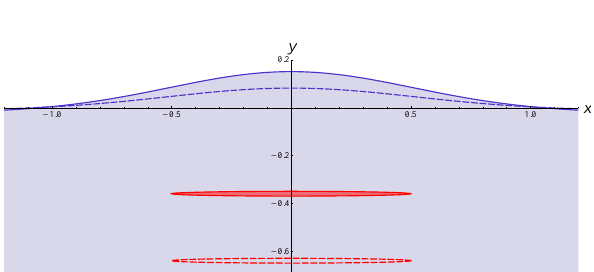
Fig. 3. Formation of inertial fluid layer by fast rising of the obstacle: a = 0 . 5 , λ = 15 .